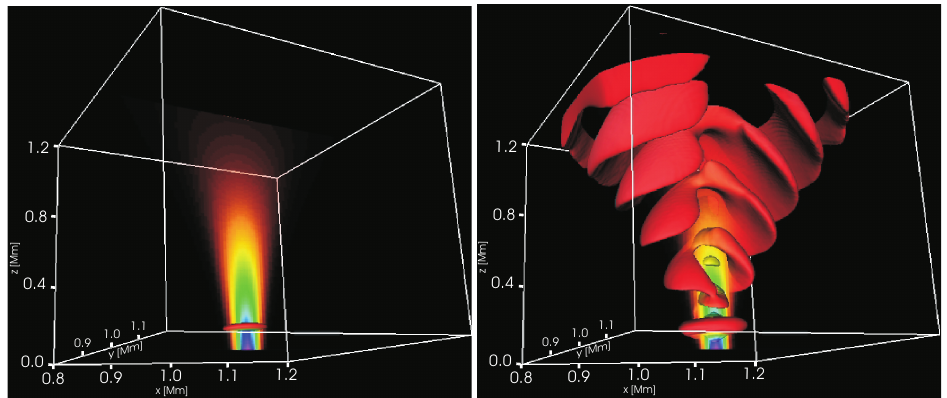
Fig. 3. Snapshots showing the iso-surfaces of the horizontal velocity component V x during numerical simulation. From left to the right the snapshots are at t = 7 . 2, 312s at the centre of the numerical domain we have overplotted the 2-D vertical slice of the background B z component of the magnetic field. Note, rendering of the 3-D numerical data has been constructed using the VAPOR visualisation package.